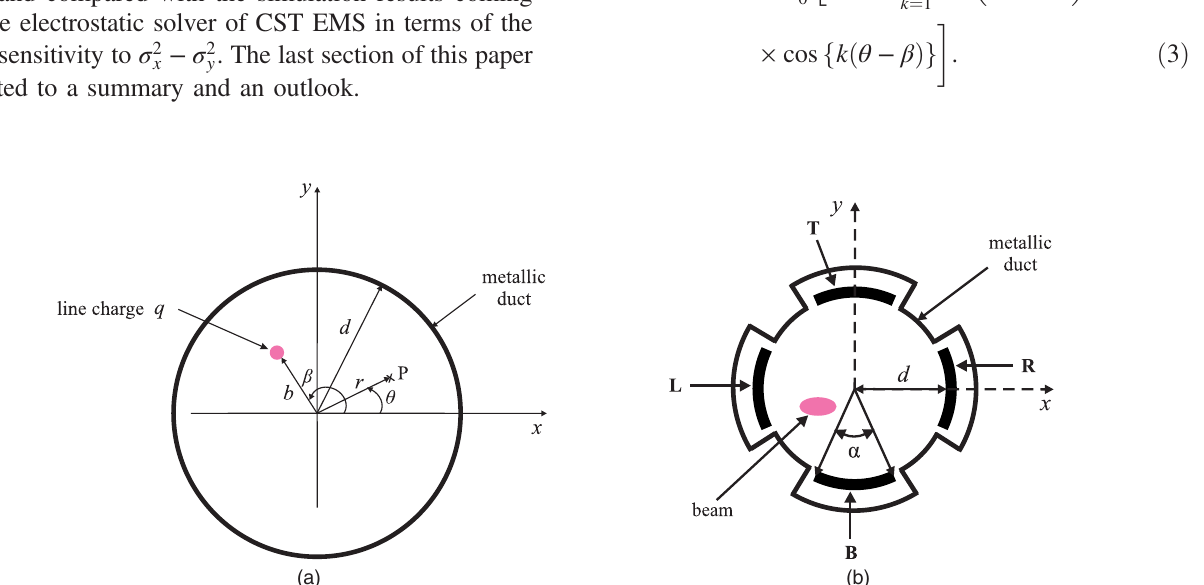
FIG. 1. (a) Line charge inside a metallic duct. (b) Cross section of the symmetrical four-electrodes pickup model used for